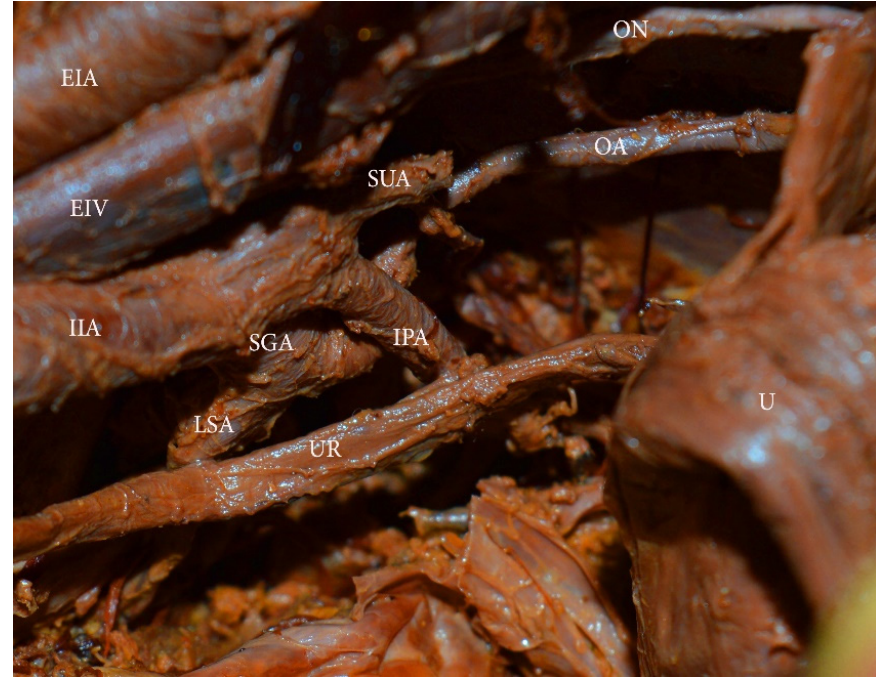
Figure 12. Obturator artery arising from the posterior branch of the IIA. U—uterus, EIA—external iliac artery, EIV—external iliac vein, IIA—internal iliac artery, SGA—superior gluteal artery, LSA— lateral sacral artery, IPA—internal pudendal artery, OA—obturator artery, ON—obturator nerve, SUA—severed uterine artery.